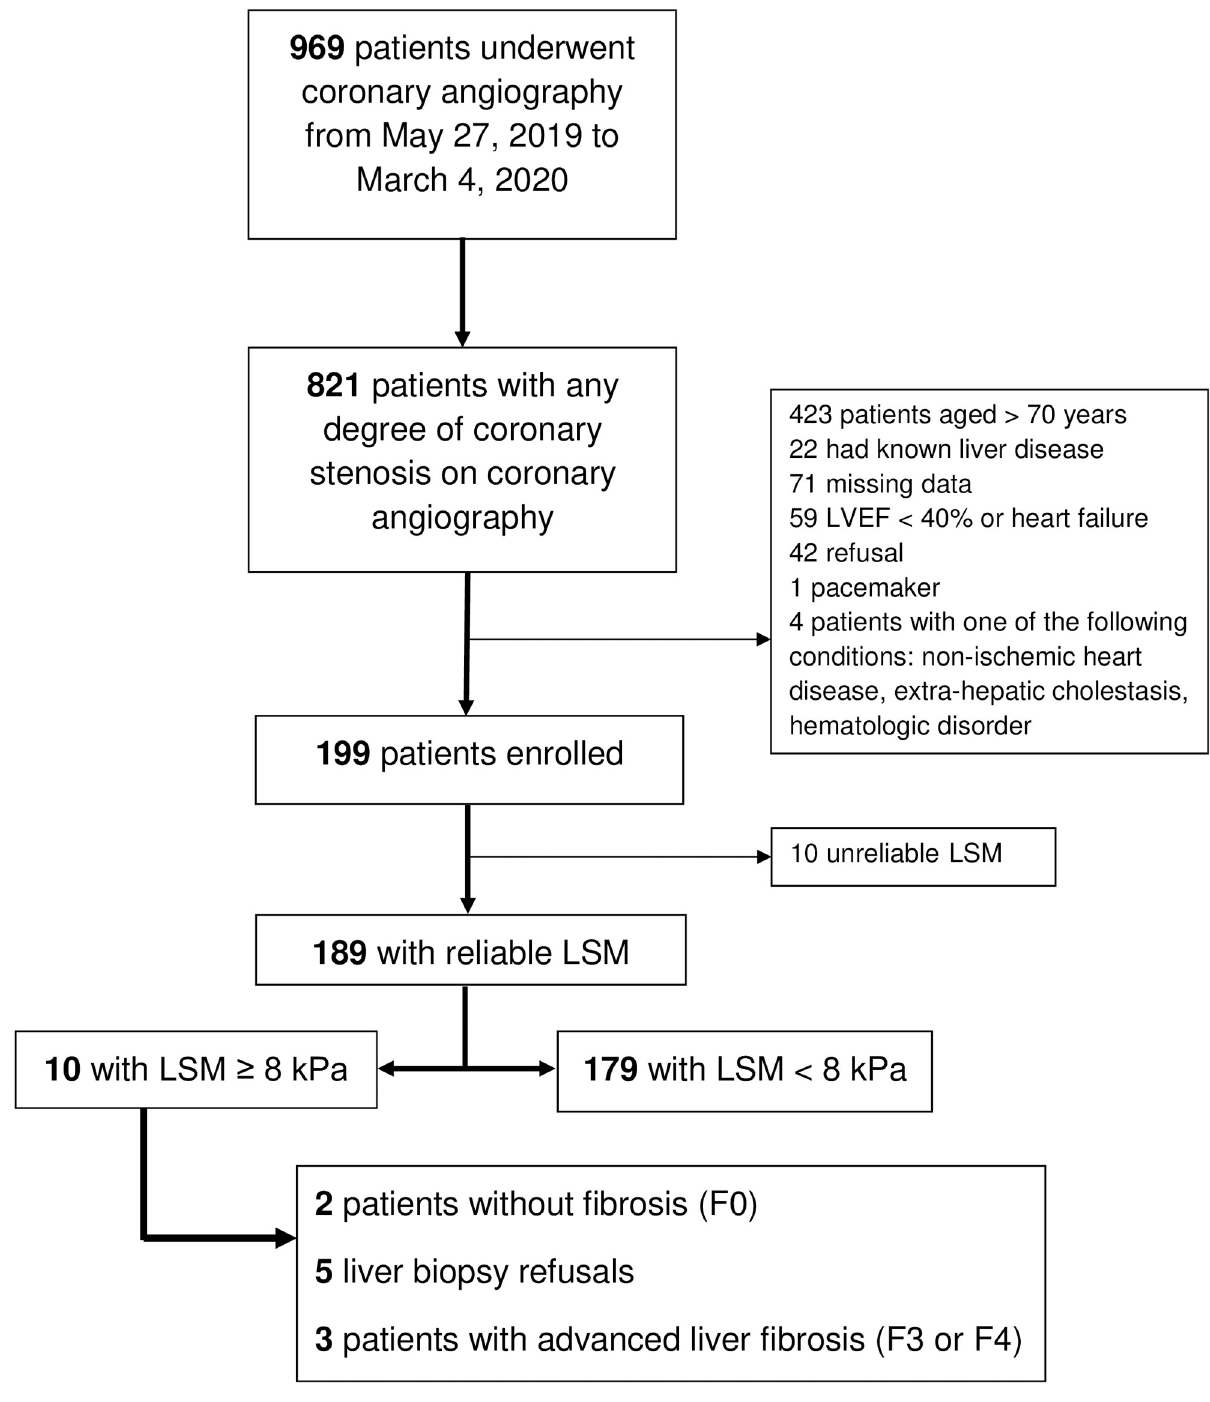
Fig 1. Flowchart of the CoroNASH study. LSM, liver stiffness measurements; LVEF, left ventricular ejection fraction. https://doi.org/10.1371/journal.pone.0266965.g001 46.2% of our cohort. Only 12 patients drank excessively and only one of them had LSM � 8 kPa (alcohol consumption 60 g/day) together with metabolic syndrome. All patients were sero- negative for hepatitis B surface antigen and antibodies to hepatitis C, 6 patients had both anti- HBc and anti-HBs antibodies and only one carried isolated anti-HBc antibodies. No patients